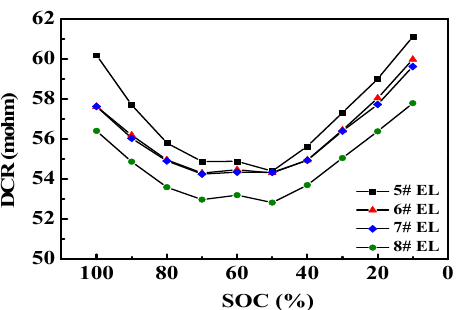
Figure 6. Discharge capacity retention (DCR) discharge at room temperature.